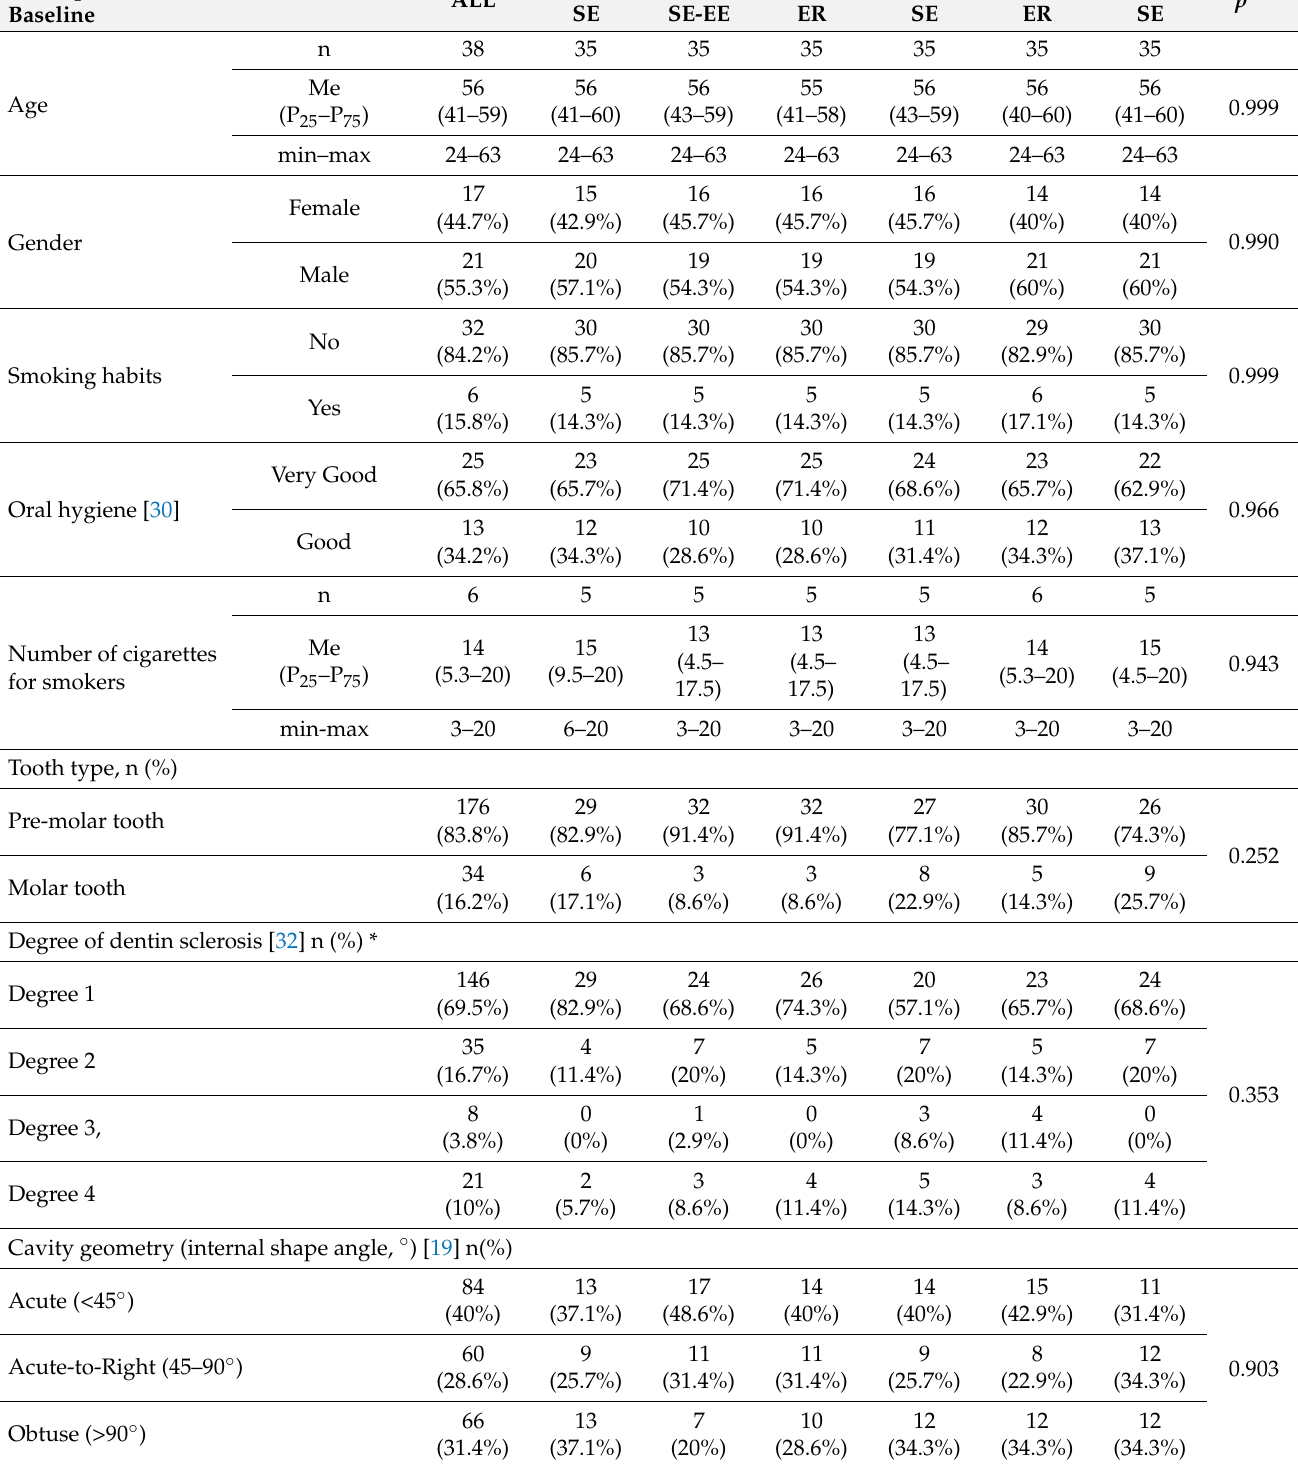
Table 2. All participants’ and NCCL restorations’ characteristics, counts (n), and percentages (%) at baseline, allocated to the control (FBDC-SE; FBDC-SE-EE) and study (FBU and ADU)